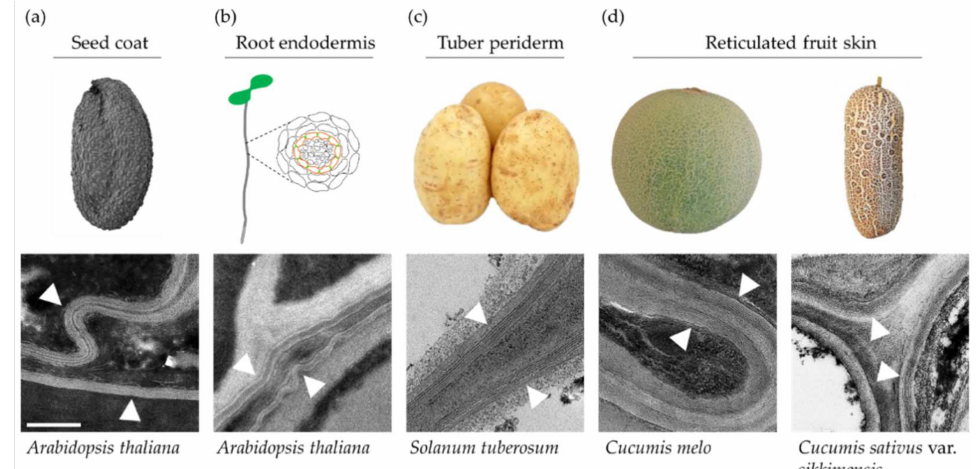
Figure 2. Examples of the deposition of suberin lamellae in plants. ( a ) Suberin lamellae in Arabidopsis thaliana seed coat integuments. ( b ) Suberin lamellae in the Arabidopsis thaliana root endodermis cell layer. ( c ) Suberin lamellae in the periderm tissue of potato ( Solanum tuberosum ) tuber skin. ( d ) Suberin lamellae in the reticulated fruit skin of melon ( Cucumis melo ) and cucumber ( Cucumis sativus var. sikkimensis ) varieties. Lower panels are transmission electron microscopy images representing suberin lamellae (indicated by white arrowheads) in different tissues. Scale bar = 200 nm.